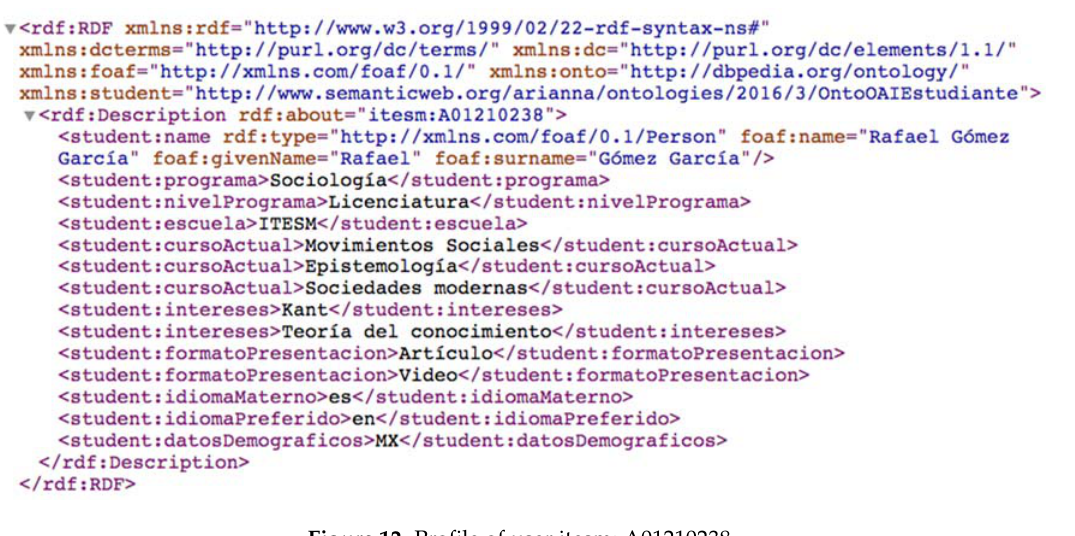
Figure 12. Profile of user itesm: A01210238.